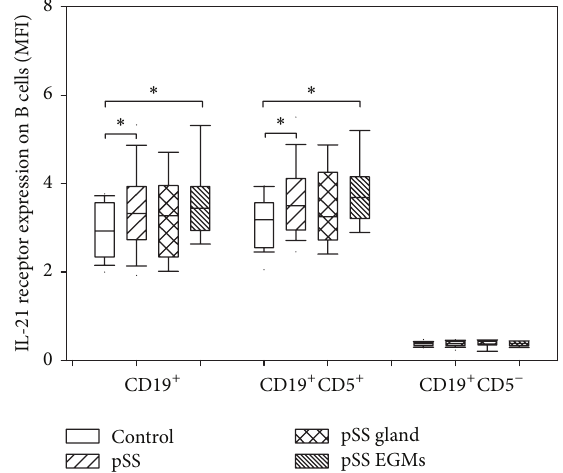
Figure 2: Interleukin-21 receptor expression of B cell subsets. Box plots show median, upper, and lower quartiles; lines extending vertically from boxes indicate 5–95 percentile ranges. Statistically significant differences are indicated by ∗